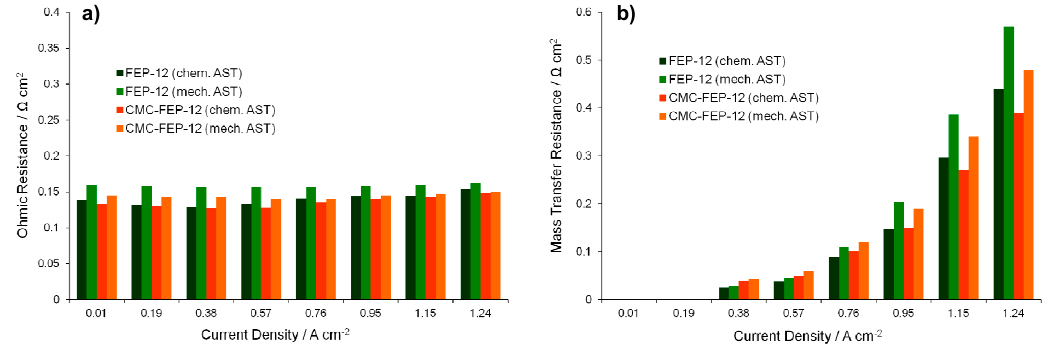
Figure 13. Ohmic ( a ); and mass transfer resistances ( b ) as a function of the current density, obtained with 1000 h chemically and mechanically aged GDMs.